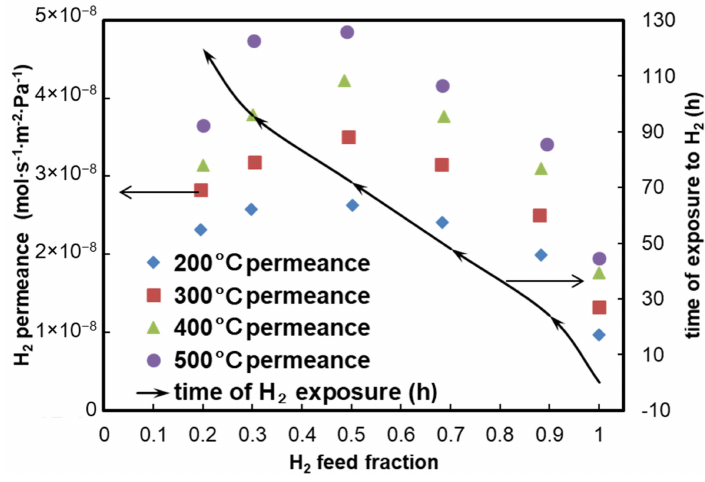
Figure 8. The permeation performance of H 2